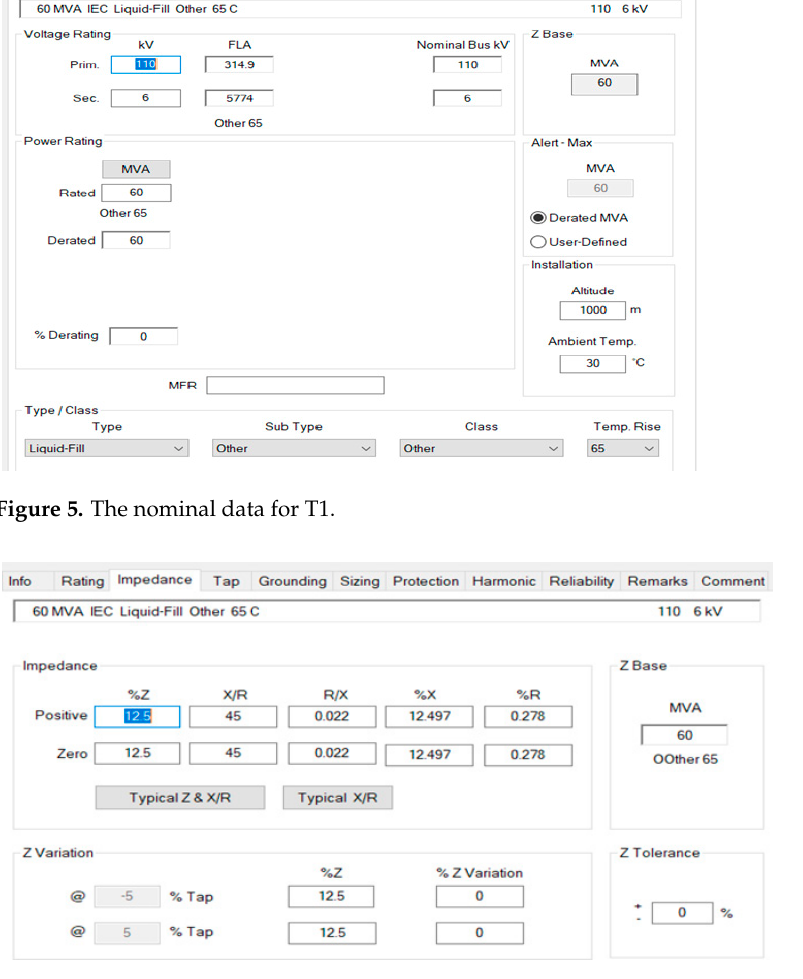
Figure 8. Percent impedance values for T5. Interpretation of the Simulated Three-Phase Short-Circuit at Transformer T1 1.